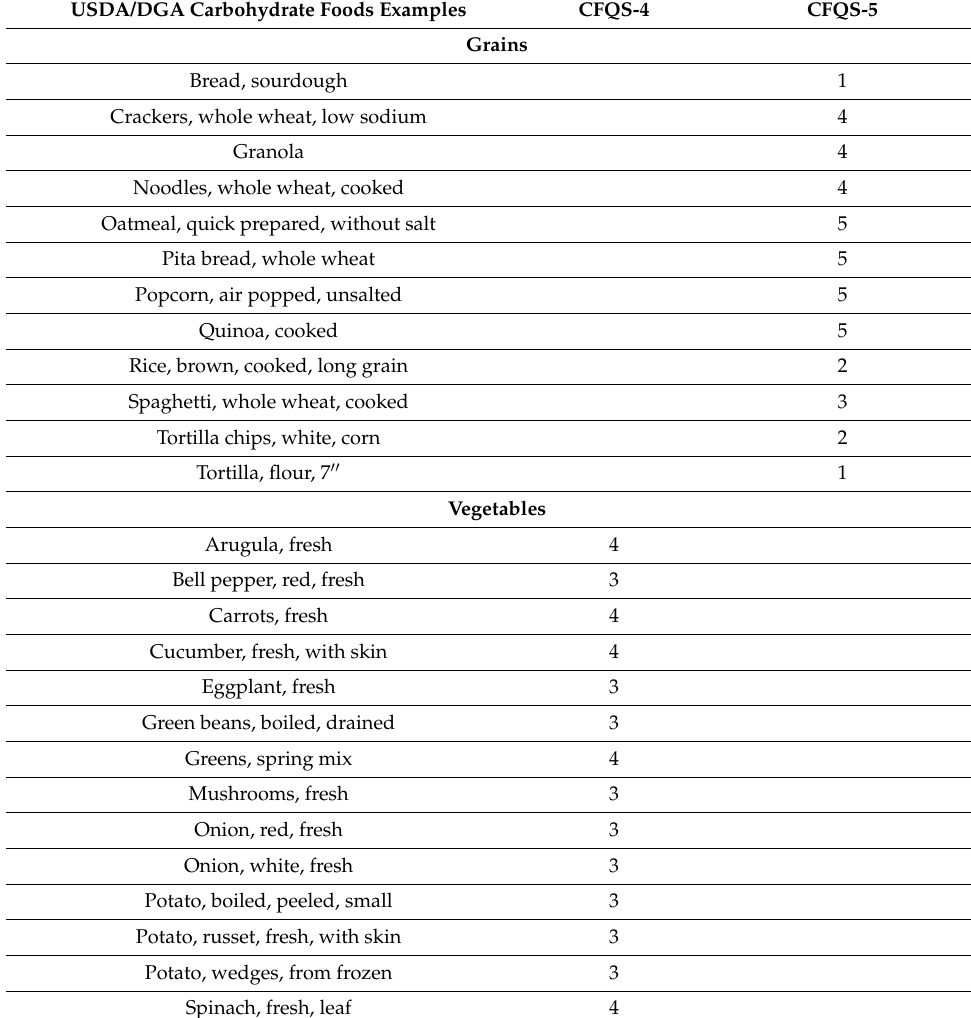
Table 1. CFQS Models Applied to Foods that Align with DGA—Healthy Dietary Patterns and the USDA Thrifty Food